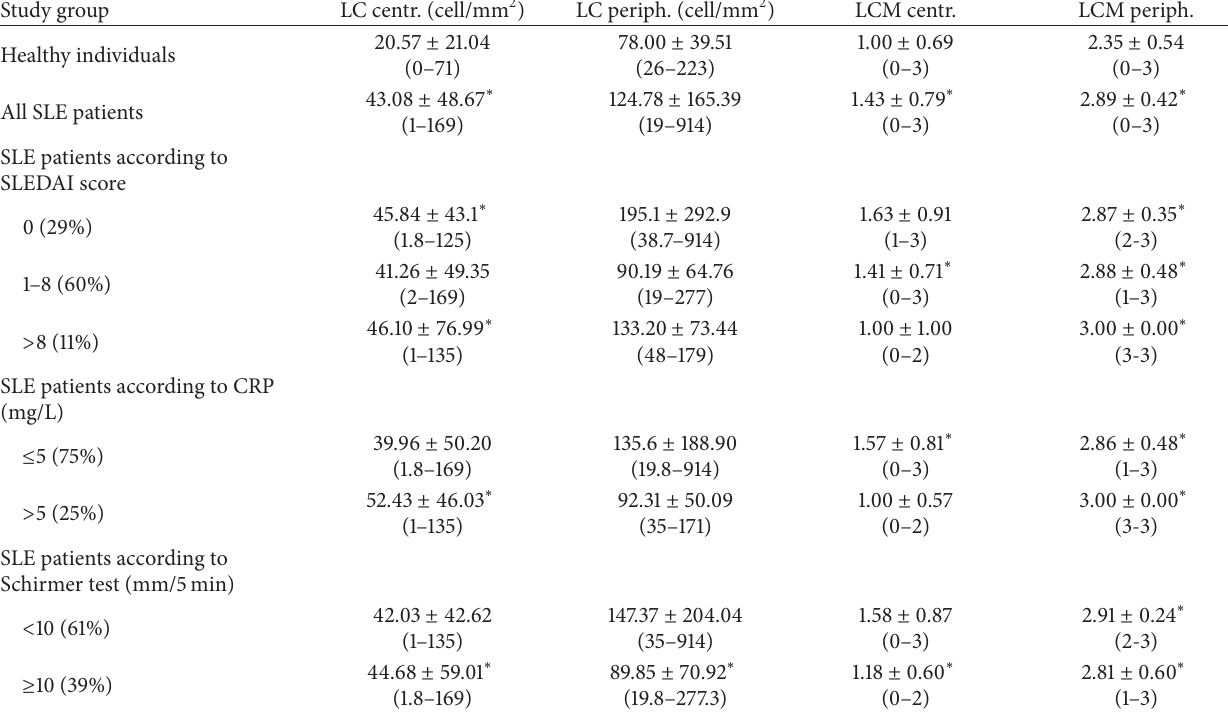
Table 2: Confocal microscopy results in different subgroups of SLE patients.